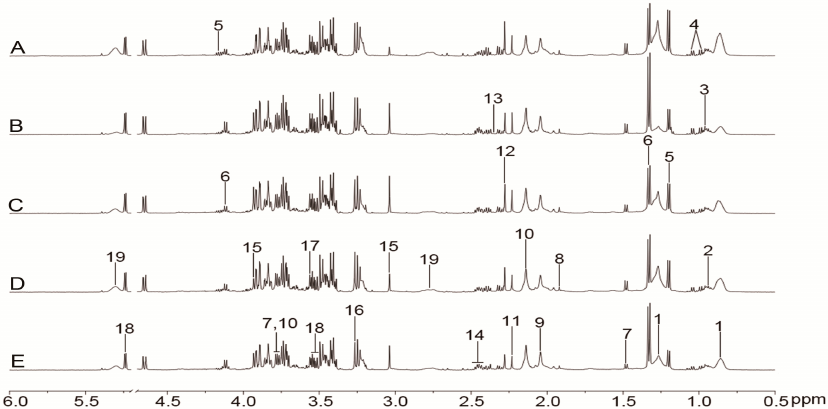
Figure 3. Representative 1 H-NMR spectra (0.5–6.0 ppm) of plasma for the control ( A ), model ( B ),